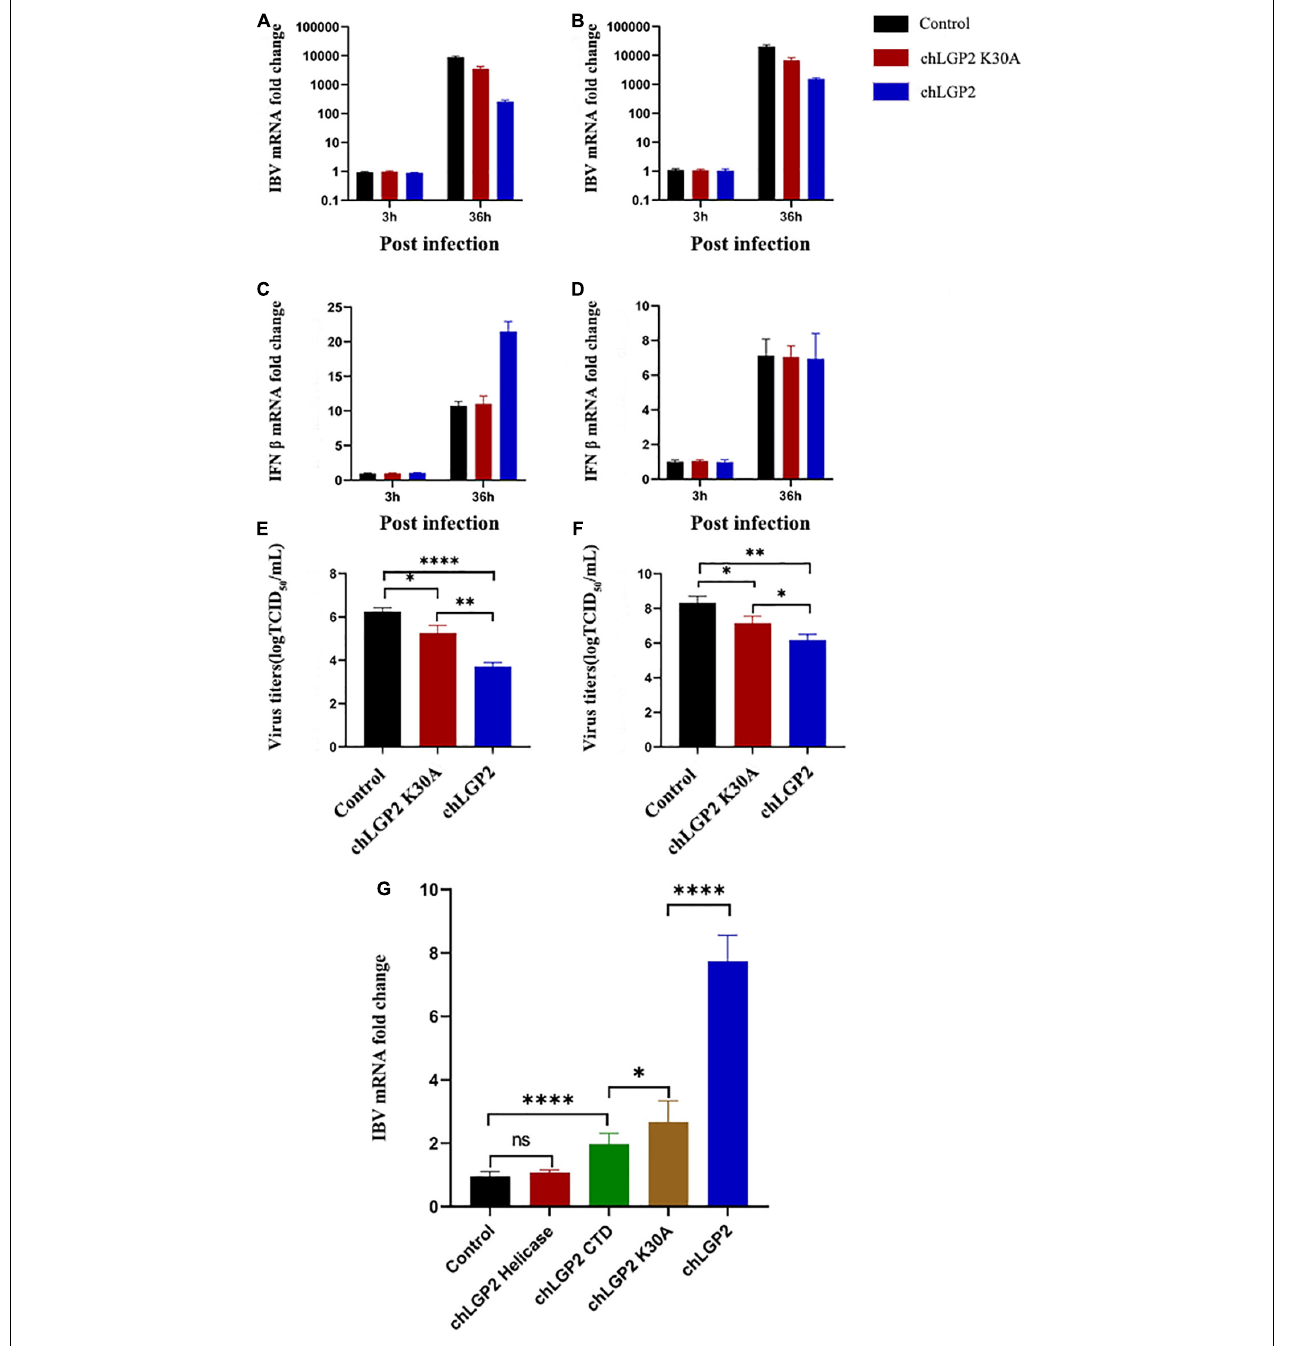
FIGURE 3 | Effect of chLGP2 ATPase activity and individual domains on IBV RNA binding. Compared with the control, chLGP2 K30A inhibited the replication of IBV in both (A) HD11 and (B) DF-1 cells at 36 h post-infection. However, chLGP2 K30A did not affect the production of IFN- β in (C) HD11 and (D) DF-1 cells. The mutant decreased the titer of the IBV B strain, but the inhibitory effect was weaker than that of wild type in both (E) HD11 and (F) DF-1 cells. (G) The IBV RNA binding ability of different chLGP2 constructs was as follows: chLGP2 > K30A > CTD > Helicase. Data are the mean values of three independent experiments, and error bars denote mean ± SDM. ∗ P < 0.05; ∗∗ P < 0.01; ∗∗∗∗ P < 0.0001; ns means not